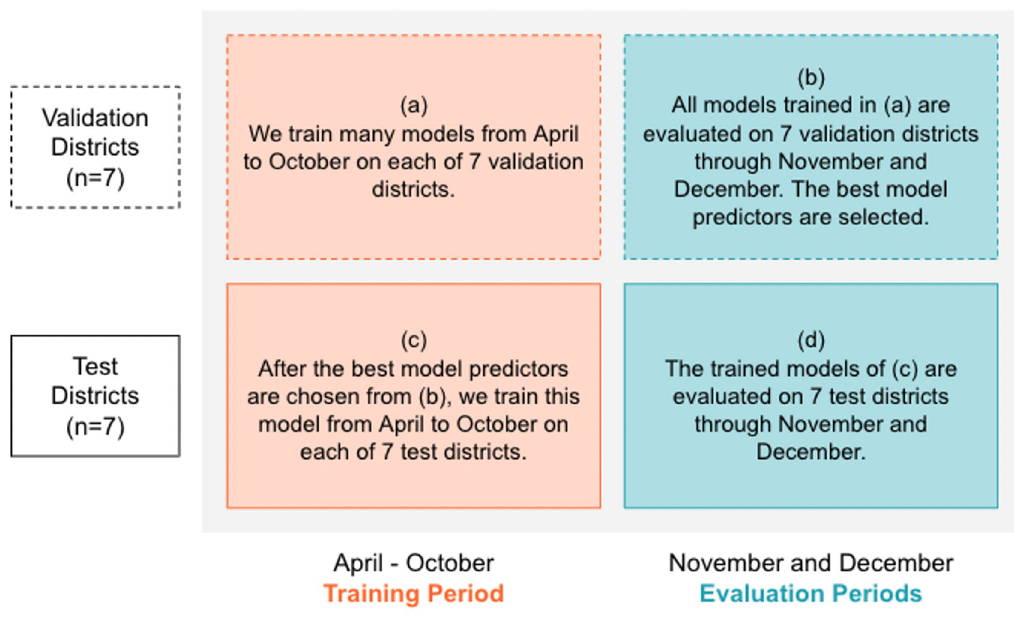
Fig 2. Overview of our predictive modeling